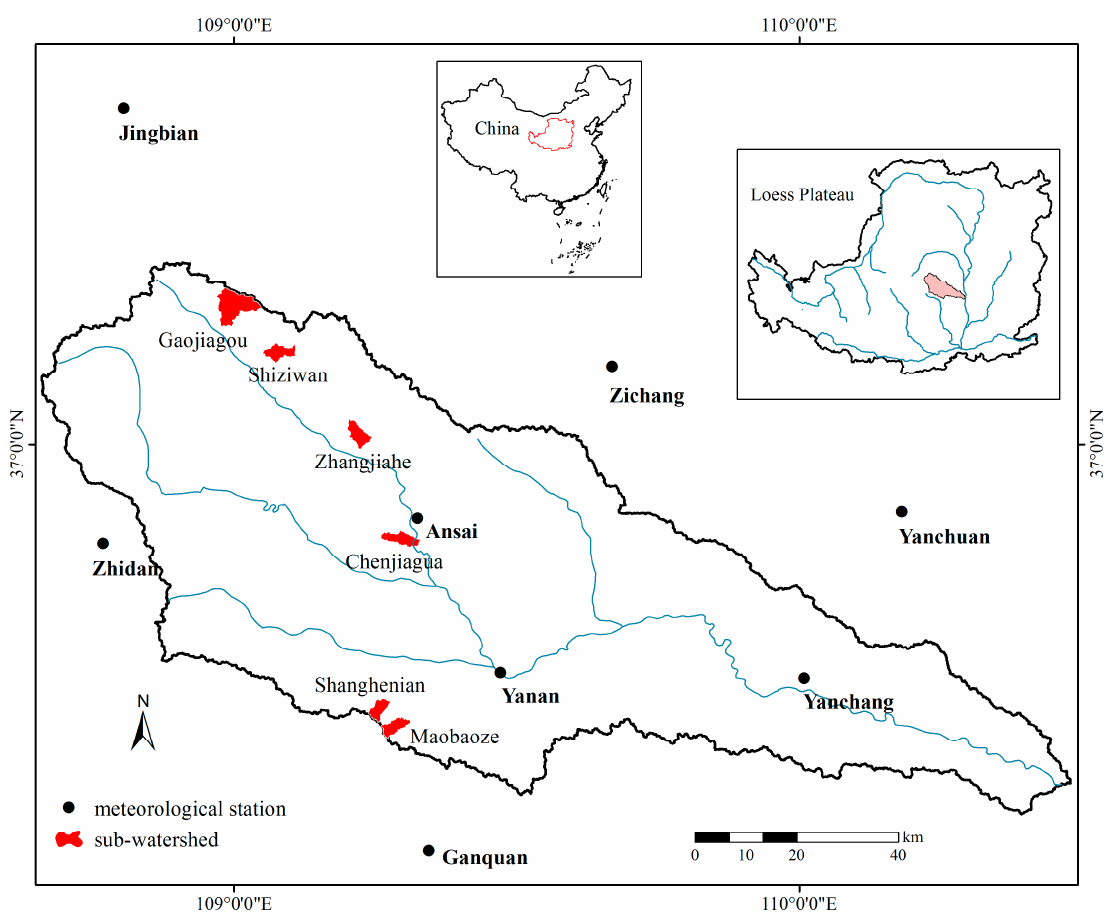
Figure 1. Location and distribution of the six sub-watersheds and meteorological stations in the Yanhe watershed.